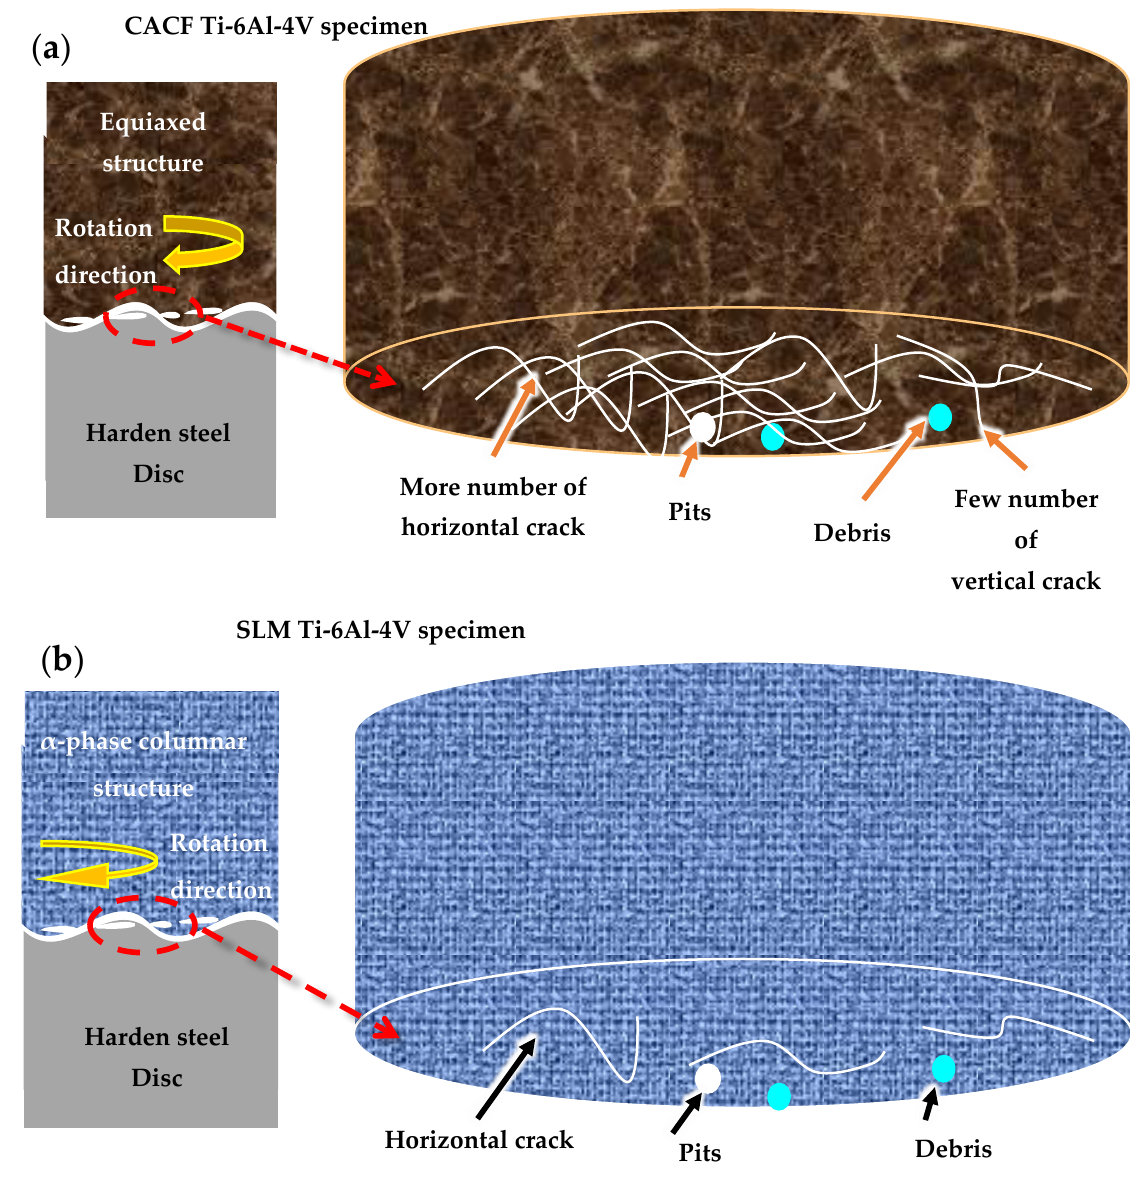
Figure 8. Schematic representation of wear mechanism: ( a , b ) CACF and SLM specimens, respec- tively.